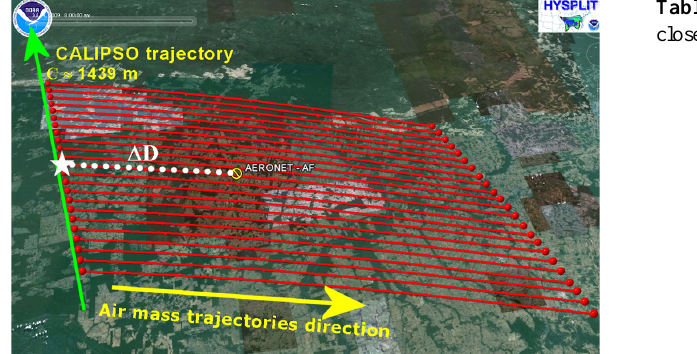
Fig. 3. HYSPLIT backward trajectories in the region of the Alta Floresta AERONET site for 14 July of 2009. The backward tra- jectories start around the time of CALIPSO’s closest approach, at 17:41UTC. 1D is the closest distance between CALIPSO tra- jectory and the AERONET site, in this case 67.3km. The initial lat/long coordinates have been used as the central values of lat/long for each 5km horizontal resolution aerosol-layer profiles. The ini- tial altitude for each trajectory, i.e., the backscatter centroids, was in this case 1439m.